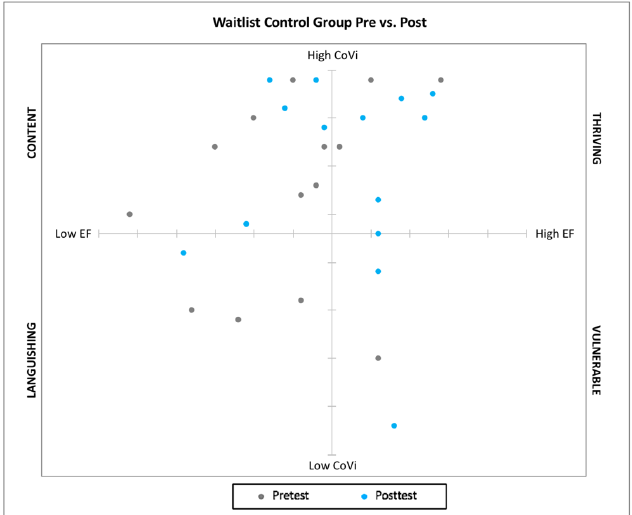
Figure 4. Waitlist Control Group Student Profiles at Pretest and Posttest . EF = executive function- ing; CoVi = student covitality. Map illustrating multidimensional student profiles according to the dual-factor model of school-based wellbeing measured at pretest (gray) and posttest (blue).